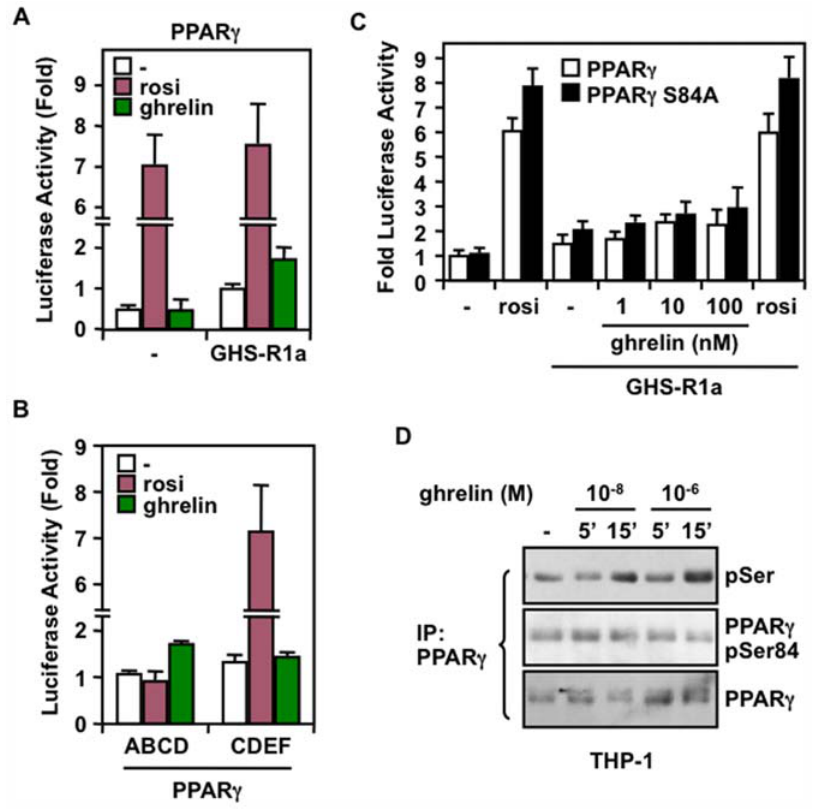
Figure 2. Ghrelin induces PPAR c activation and phosphorylation independently of serine-84. ( A ) Ghrelin promotes PPAR c activity in 293 cells transfected with a UAStkLuc reporter plasmid in the presence of GHS-R1a and Gal4 fusion of full-length PPAR c 1 expression plasmids. Transfected cells were treated with 10 nM ghrelin or 1.4 m M rosiglitazone for 20 h and harvested for luciferase activity. Values are normalized to b -galactosidase activity and expressed as fold changes in luciferase activity compared with untreated cells expressing GHS-R1a. Error bars represent the mean 6 SEM of triplicate values derived from at least three independent experiments. ( B ) Similar as in (A) except that a truncated ABCD c construct lacking the ligand binding domain, or a CDEF c construct lacking the N-terminal region were used. ( C ) Activation of PPAR c by ghrelin is independent of serine 84. 293 cells were transfected as in (A) with an expression vector for Gal4-PPAR c or Gal4-PPAR c S84A. Cells were treated with ghrelin as indicated or with 1.4 m M rosiglitazone for 20 h. ( D ) Phosphorylation of PPAR c in serum-deprived differentiated THP-1 cells treated with increasing doses of ghrelin for the indicated time. Cell extracts were immunoprecipitated with an antibody against PPAR c and analyzed by immunoblot using antibodies against phospho-serine residue or phospho-specific to PPAR c serine-84. Samples were normalized with a different anti-PPAR c